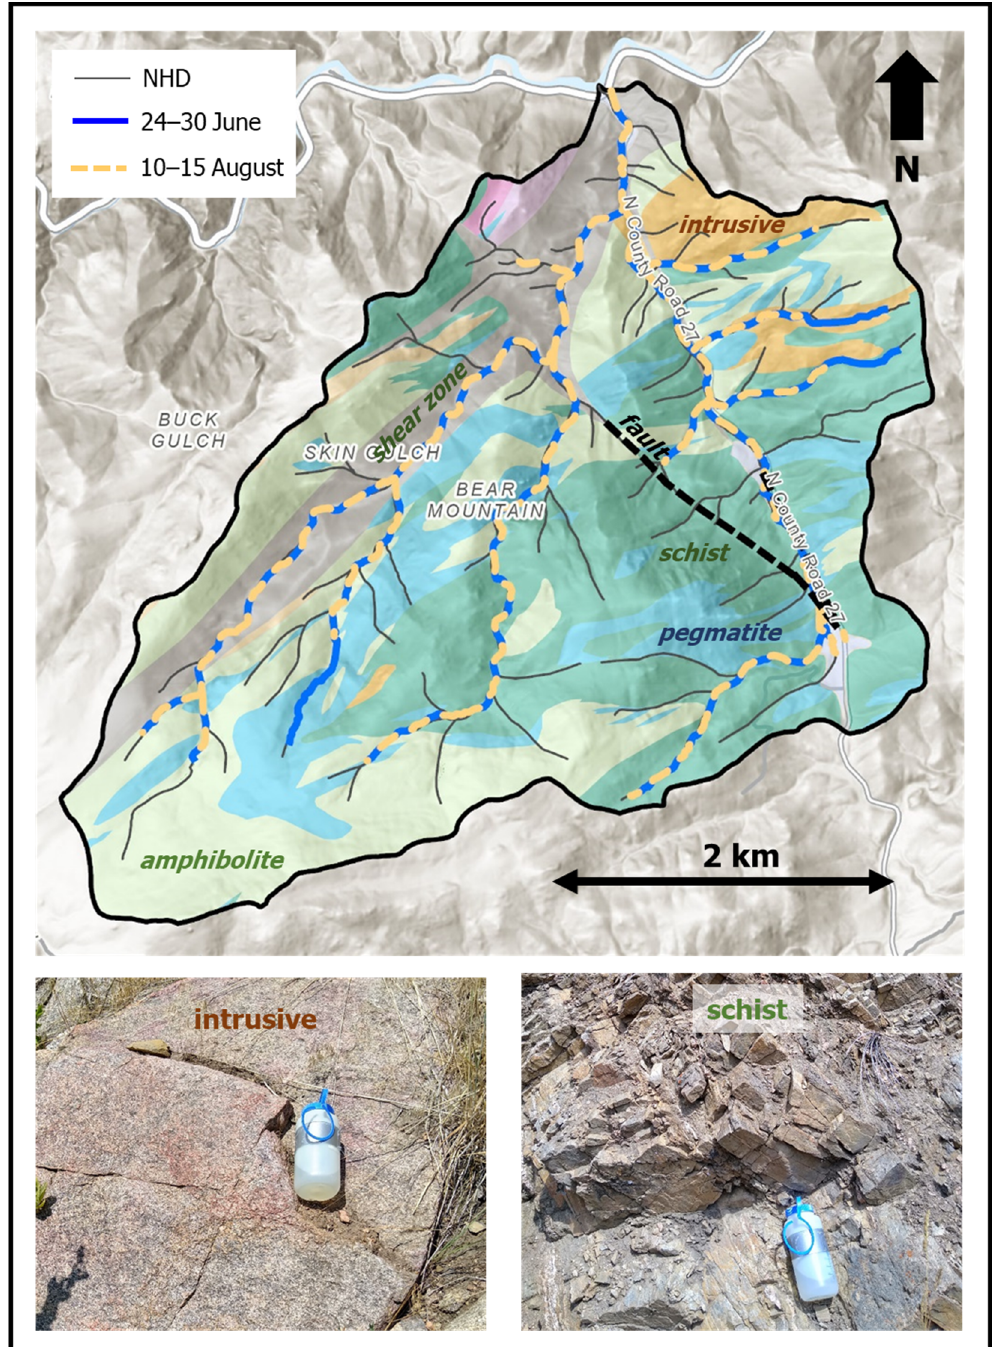
Figure 3. Skin Gulch NHD HR flowlines and field-mapped streamflow locations over a hillshade and a digitized geologic map adapted from [55]. Blue lines indicate the surface flow locations for the first field survey, and dashed orange lines overlaying the blue lines indicate the surface flow locations for the second survey. The images are examples of bedrock outcrops within the catchment.